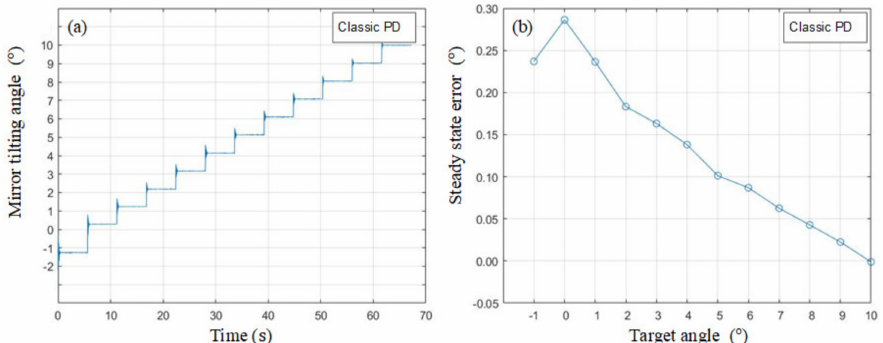
Figure 9. ( a ) Step-train response and ( b ) steady state error of the classic PD